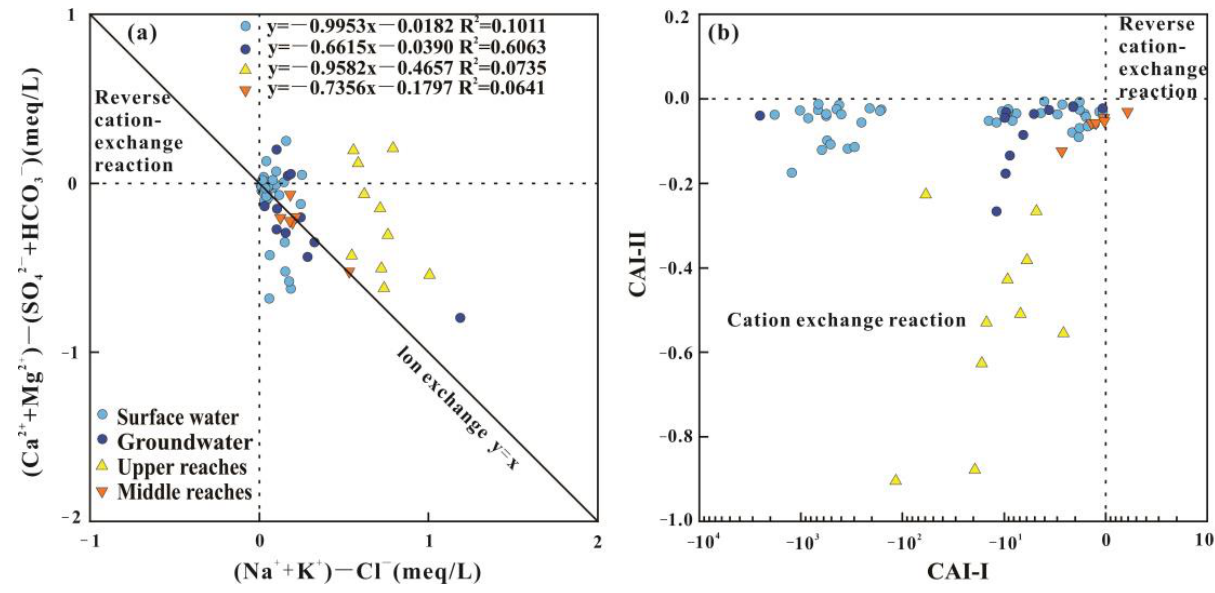
Figure 10. Ion combination ratio diagram of ion exchange. Data are from Tables 1 and 2. Cation exchange interaction can also be analyzed using the choroalkaline index [36]. Where the indices CAI-I (=(Cl − − (Na + + K + ))/Cl − ) and CAI-II (=(Cl − − (Na + + K + ))/(HCO 3 − + exchanged by Ca 2+ and Mg 2+ in the surrounding rocks, while negative values indicate the presence of reverse exchange, and the absolute value The larger the value, the stronger the ion-exchange interaction, and if the value is equal to 0, it means that there is no ion- exchange interaction in the water chemistry process. Figure 10b shows the CAI-I and CAI-II relationships of surface water, groundwater, and water samples from the lower reaches of the Yarlung-Zangbo River and the middle and upper reaches of the Yarlung-Zangbo River, upper reaches of the Yarlung-Zangbo River have been exchanged by Na + and K + in the surrounding